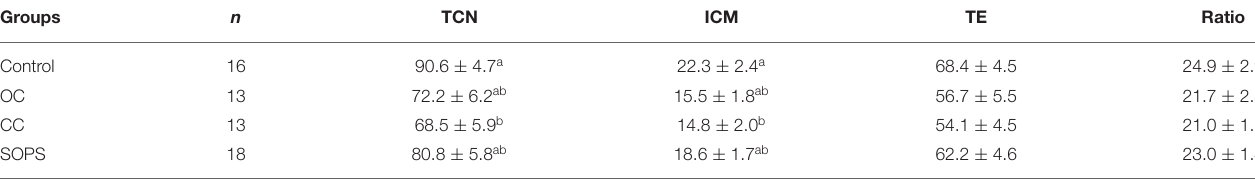
TABLE 1 | Total cell number and differential cell counts of blastocysts derived from embryos vitrified with open Cryotop ® (OC), closed Cryotop ® (CC) or SOPS systems. Groups n TCN